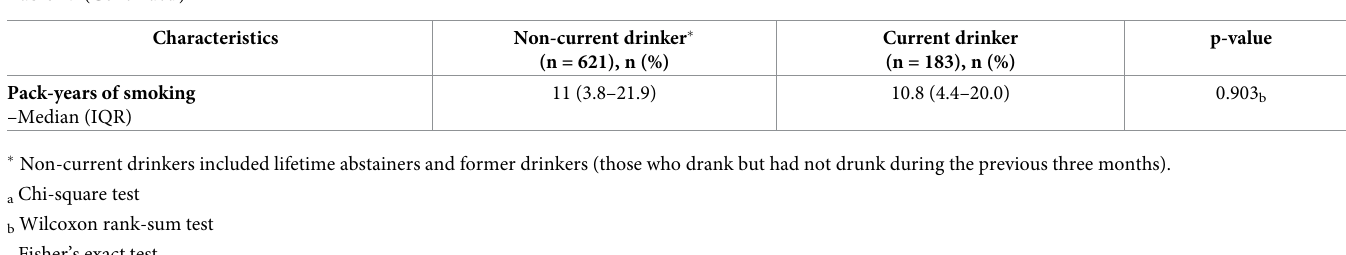
sented in Table 3. The CSQF instrument over-reported the average quantity in 39% to 50% of current drinkers, whereas the BSQF over-reported in 7% to 23%. More than half of the partici- pants reported equivalent drinking frequency by the BSQF and CSQF: 62.2% for beer, 75.0% for white spirits, 55.6% for whisky, and 60.7% for other beverages.